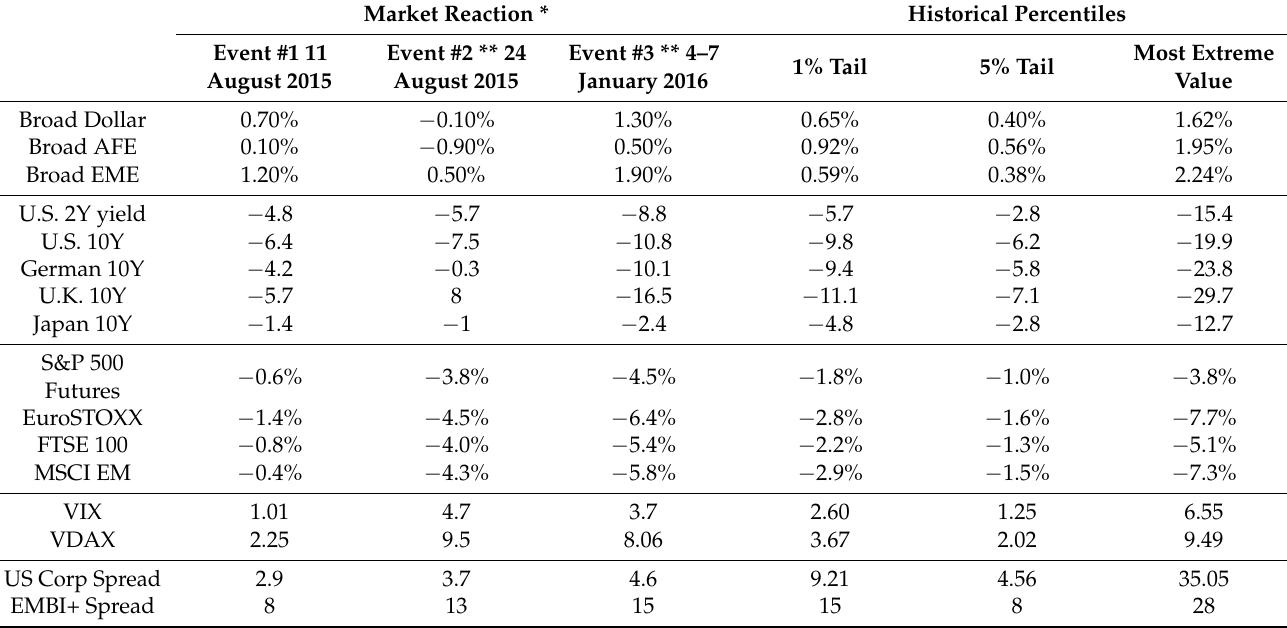
Table 8. Market reactions during China event windows in 2015–2016. Market Reaction